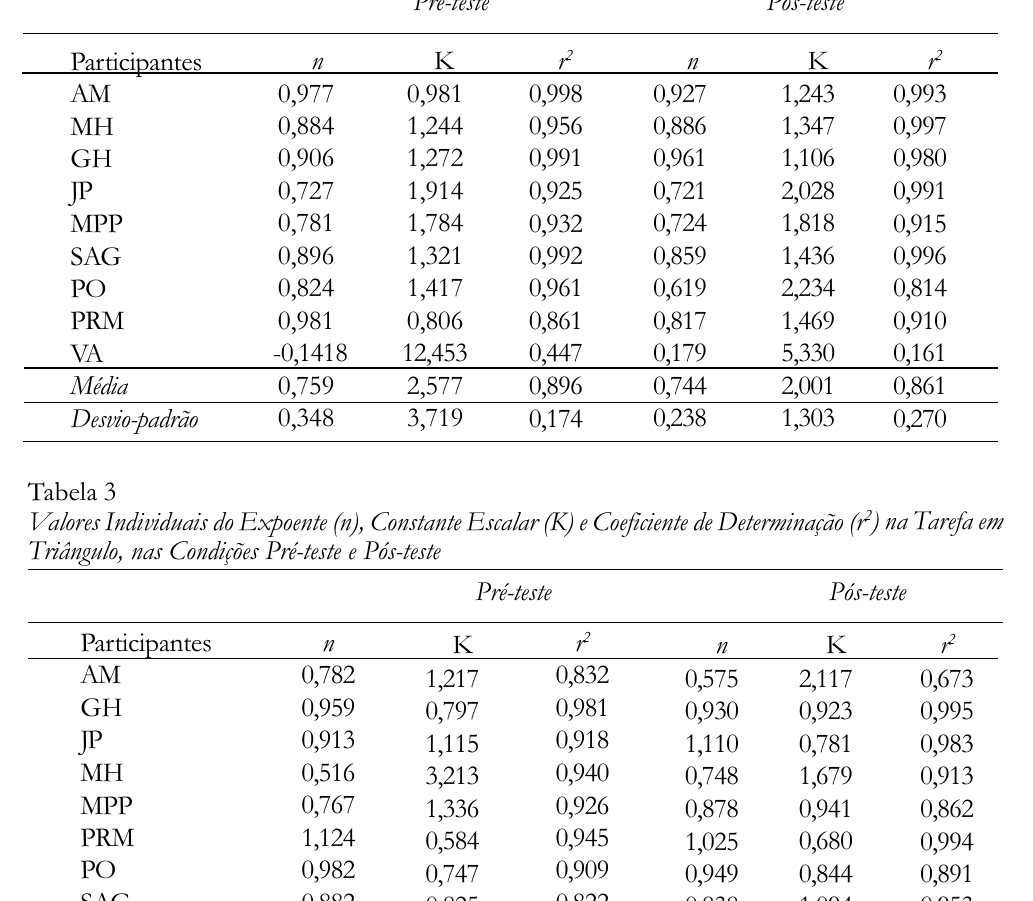
P(cid:243)s-teste